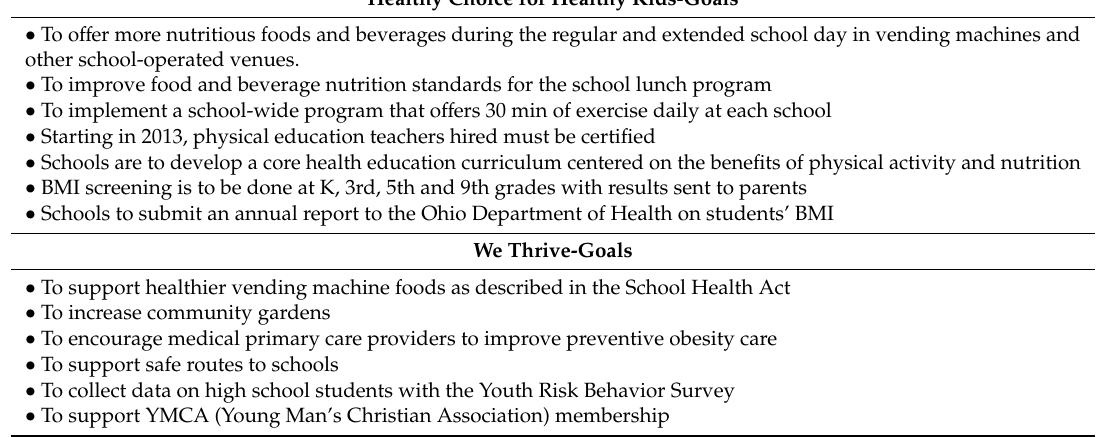
Table 2. Summary of Ohio State School Health Act—“Healthy Choices for Healthy Kids” and the CDC funded “We Thrive”